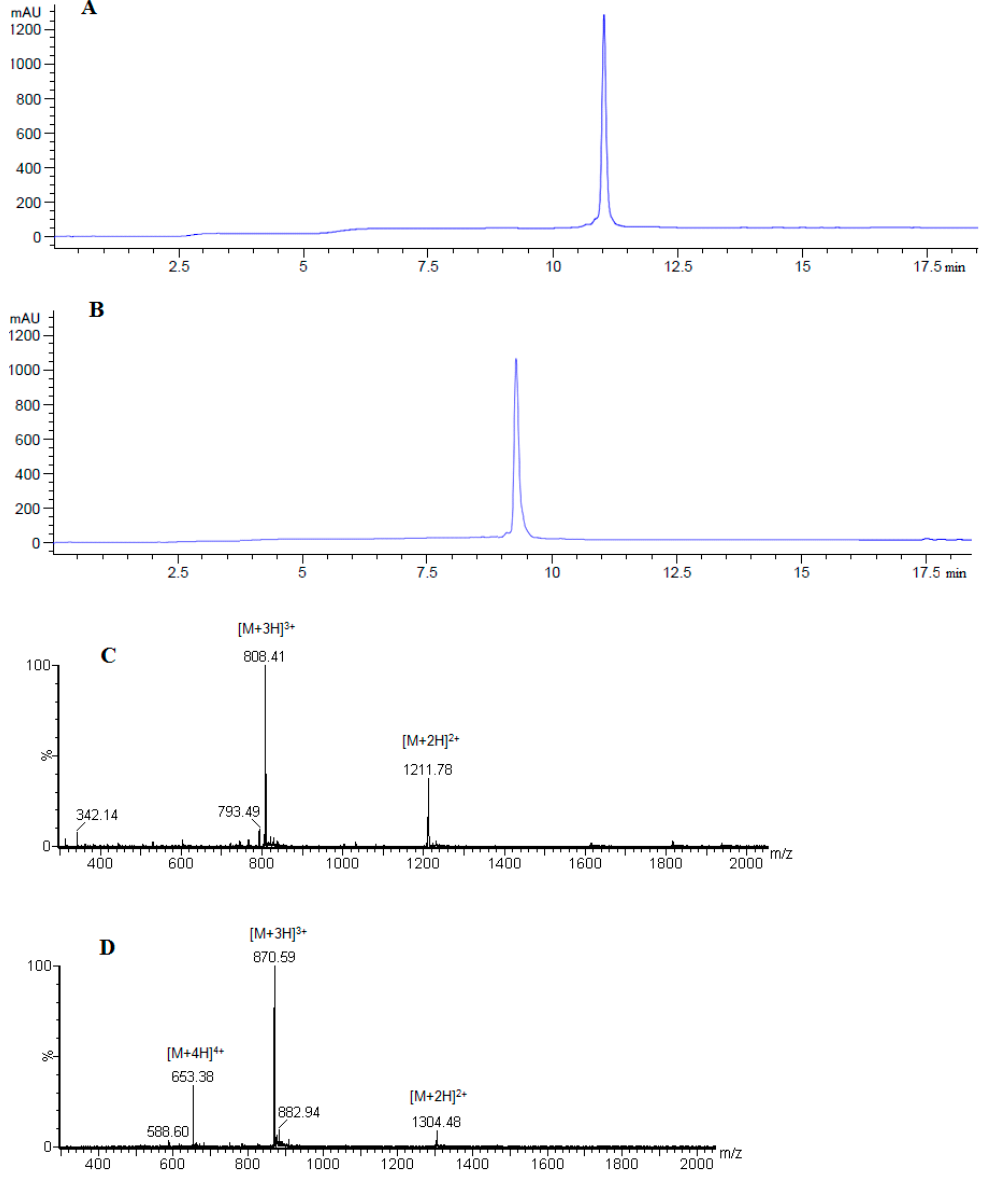
Figure 2. Analytical RP-HPLC of purified linear [Ala 41,46 ]MOG 35–55 ( A )